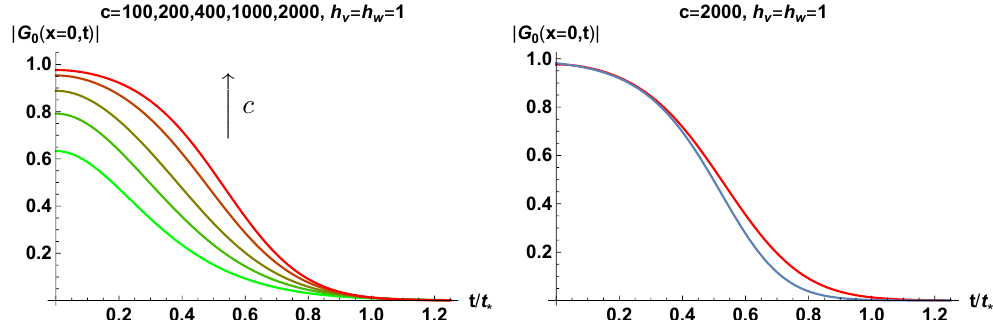
Figure 2 . The Virasoro vacuum blocks G 0 ( x; t ) in (2.28) at x = 0 as a function of t with (cid:12) = 1 (cid:0) (cid:1) and ( (cid:15) 1 ; (cid:15) 2 ; (cid:15) 3 ; (cid:15) 4 ) = (cid:0) 1 ; 1 ; 0 ; 1 . Left: increasing central charges c are shown from green to red. 4 4 2 Right: a comparison between the numerically computed vacuum block (3.10) (shown in red) and the semiclassical heavy-light vacuum block (2.29) (shown in